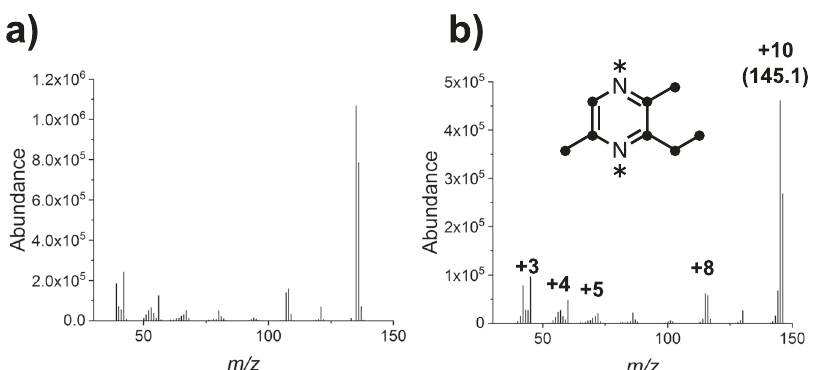
Fig. 2 EDMP production using [U- 13 C, 15 N]-L-Thr. GC-MS spectra of synthesized EDMP using unlabeled L-Thr ( a ) and [U- 13 C, 15 N]-L-Thr ( b ). 13 C and 15 N atoms are shown as circles and asterisks, respectively.